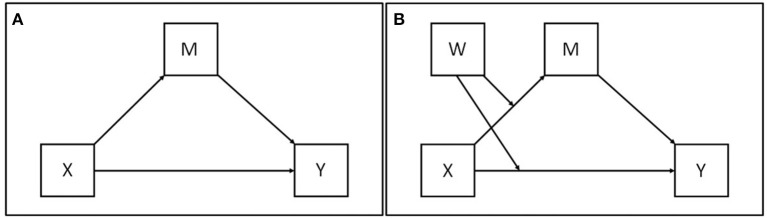
Mediator model. (A) Simplest model, two consequential variables (M) and (Y) and two antecedent variables (X) and (M), with X causally influencing Y and M, and M causally influencing Y (Hayes, 2013). (B) Conditional model of mediation and moderation, where it depicts the mediation of the effect of X on Y through M, with both direct and indirect effects of X moderated by W.